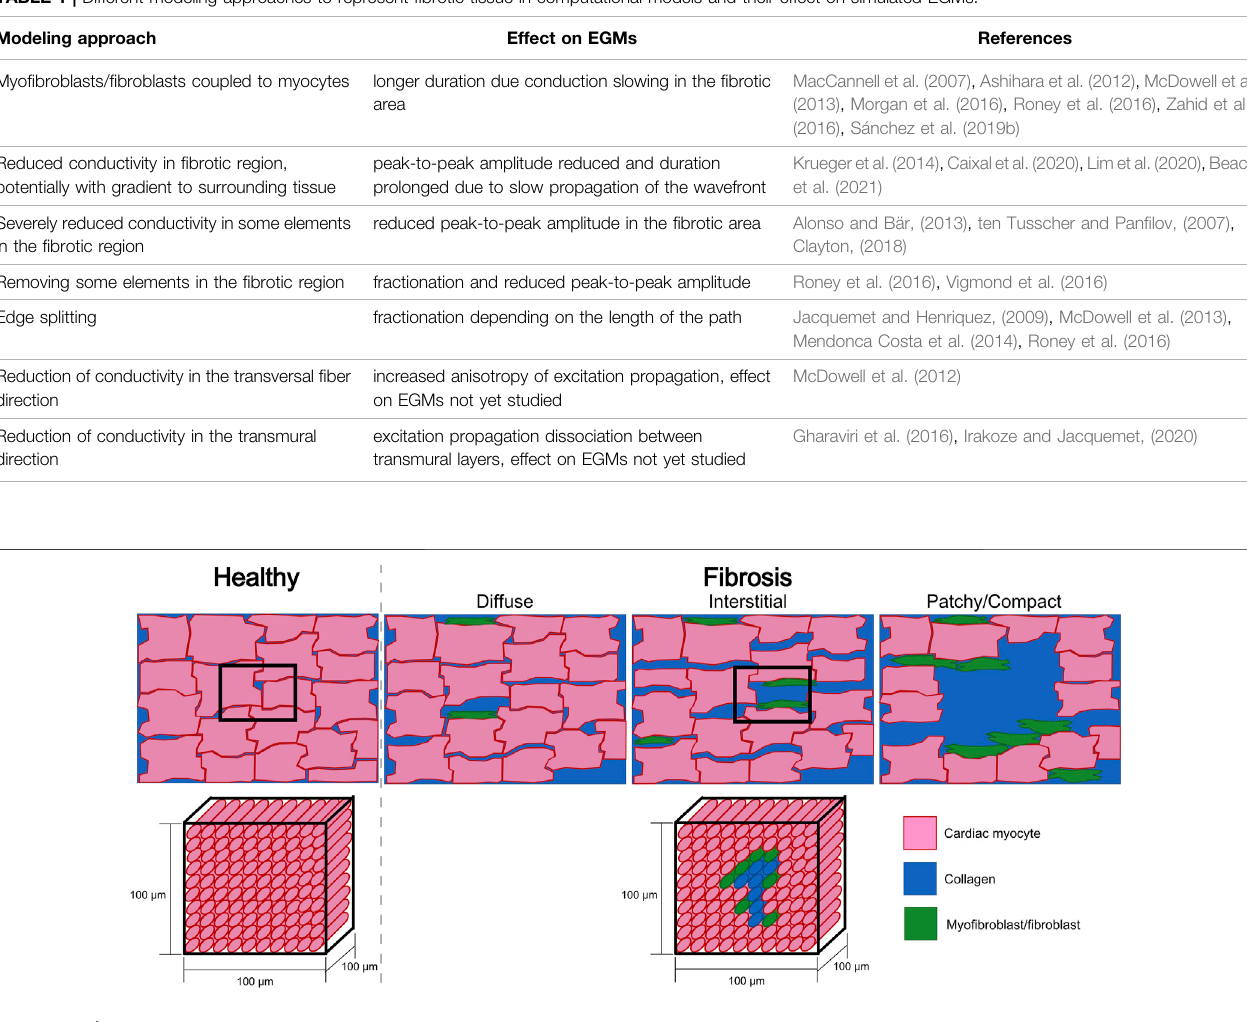
FIGURE 6 | Sketches of a tissue cut for healthy and fi brotic tissue (top row). Fibrotic sketches represent different fi brotic patterns (diffuse, interstitial, patchy or compact). The bottom row depicts the homogenization assumption where a hexahedral mesh element of 100 μ m × 100 μ m×100 μ m represents several cardiac myocytesandhastoassumeoneaveragesetofpropertiesthatdescribestheelectrophysiologyofthisgroupofcells.For fi brotictissue,homogenizationimpliesthatone elementcontainsdifferenttypesofcells(cardiacmyocytesand fi broblasts/myo fi broblasts)andcollagen.Alsotheelectrophysiologicalcharacteristicsofthispieceof tissue has to be represented by one set of effective